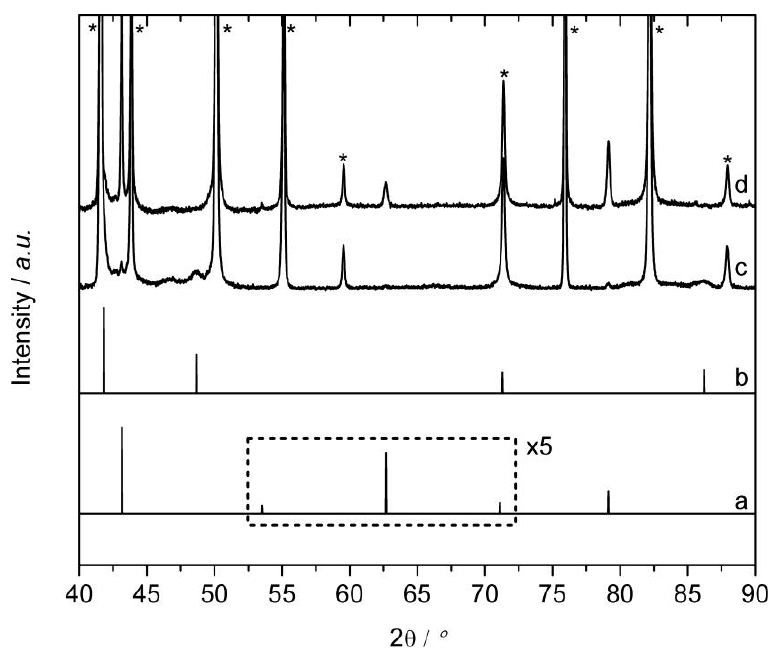
Figure 9. X-ray diffraction pattern of ( a ) theoretical ordered Cu ( b ) theoretical disordered Cu and ( d ) ordered Cu as